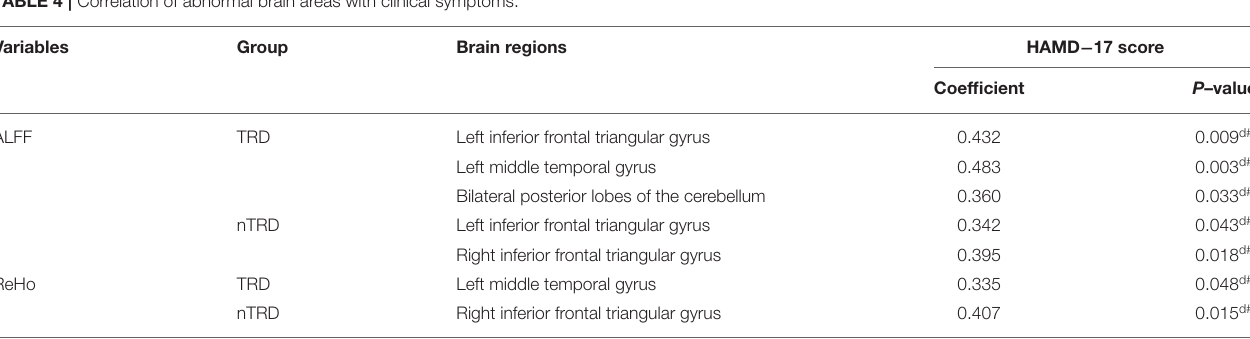
TABLE 4 | Correlation of abnormal brain areas with clinical